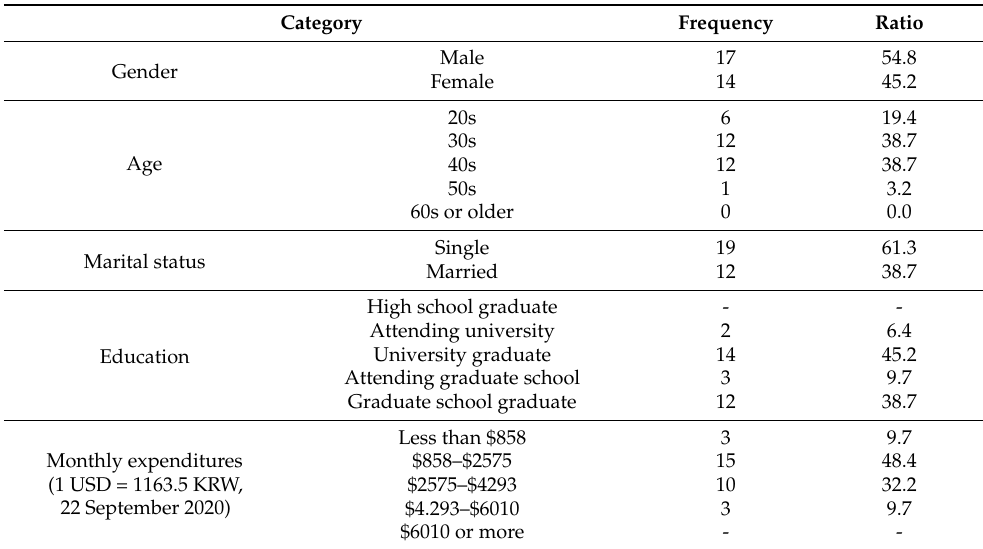
Table 5. Experts: Demographic profile of respondents in the one-group pretest–posttest design.